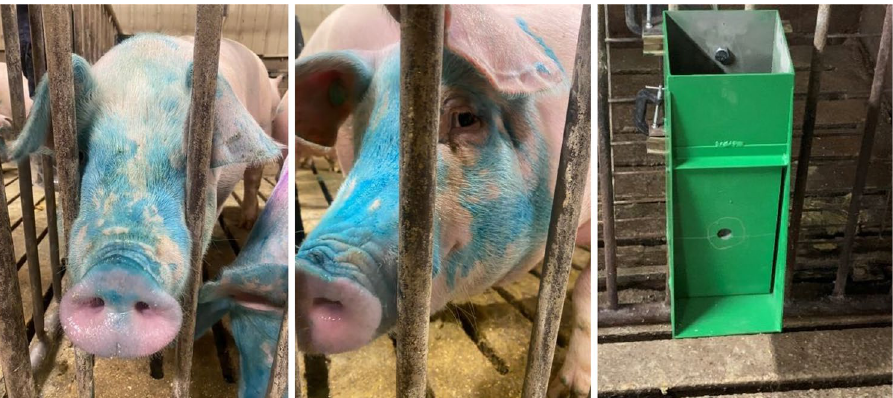
Figure 1. Example 4-month-old pigs self-vaccinated using an EE device and a picture of the sprayer device. Note the blue dye is added to the vaccine to identify that the pig has been exposed to the vaccine. Note also that the EE-device delivered vaccine to each pig’s nasal, oral and ocular mucous membranes. When a pig presses on the lower half of the front panel, a trigger is pressed, and 4 mL is delivered. This EE device in this form requires no external power or plumbing. A video of sprayer operation is given in Supplementary